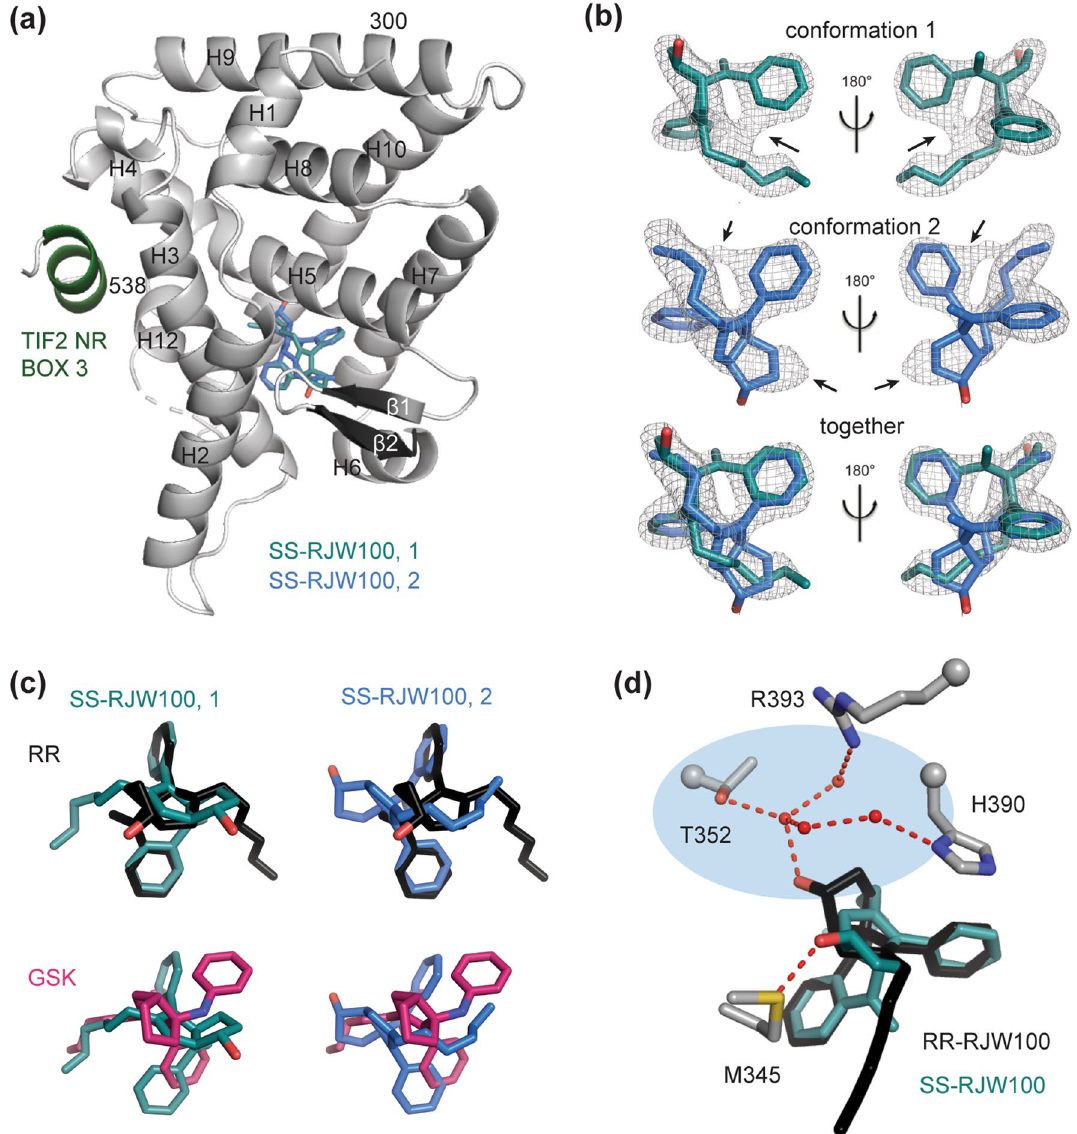
Figure 5. Crystal structure of LRH-1 bound to SS-RJW100. ( a ) Overall structure of the LRH-1 LBD (grey) bound to SS-RJW100 (two conformers, cyan and blue). The complex was crystallized with a fragment of the Transcriptional Intermediary Factor 2 (Tif2) coactivator, shown in green . H, helix. ( b ) Omit maps (F O -F C , contoured at 2 σ) showing the justification for modelling two orientations of the ligand. ( c ) Superpositions of SS-RJW100 with RR-RJW100 ( top ) and related molecule GSK8470 ( bottom ). ( d ) Different contacts made by SS-RJW100 and RR-RJW100 hydroxyl groups in the LRH-1 binding pocket. Highlighted in blue is the network of water molecules (red spheres) and a group of residues that they coordinate. Red dotted lines indicate hydrogen bonds. RR-RJW100, but not SS-RJW100 makes a water-meditated hydrogen bond with residue